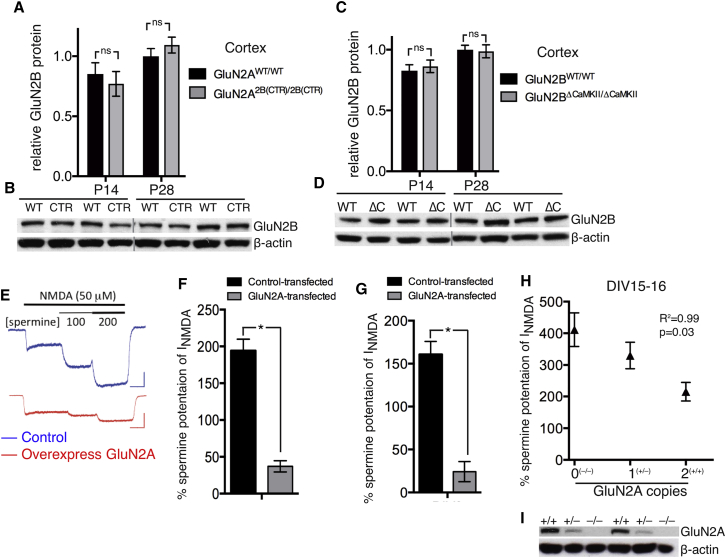
GluN2A Expression Is Sufficient to Displace GluN2B from NMDARs(A–D) Total GluN2B expression was measured in extracts from the neocortex at the indicated stages for the indicated genotypes (n = 8 per genotype). (A) and (B) show quantitation and example blots, respectively, for GluN2AWT/WT versus GluN2A2B(CTR)/2B(CTR). (C) and (D) show quantitation and example blots, respectively, for GluN2AWT/WT vs. GluN2BΔCaMKII/ΔCaMKII.(E–G) Ectopic GluN2A expression is sufficient to displace GluN2B from NMDARs. Young mouse (E and F) and rat (G) neurons at DIV7 were transfected with a control (β-globin) or GluN2A-encoding vector and spermine (100 μM) potentiation of NMDAR currents measured 72 hr later. ∗p < 0.05 (F: n = 10 of both condition; G: n = 8 control; n = 10 GluN2A).(H) Percentage potentiation of NMDAR currents by spermine (200 μM) in DIV15 or DIV16 rat cortical neurons was measured at the indicated stages for GluN2A+/+, GluN2A+/−, and GluN2A−/− genotypes. Person r correlation coefficient: −0.9954; p = 0.031 (one-tailed test); n = 12 cells per genotype.(I) Western blot illustrating GluN2A expression in GluN2A+/+, GluN2A+/–, and GluN2A–/– neurons.(I) A western blot confirming the absence of GluN2A expression in GluN2A−/− and an intermediate expression level in GluN2A+/− neurons.